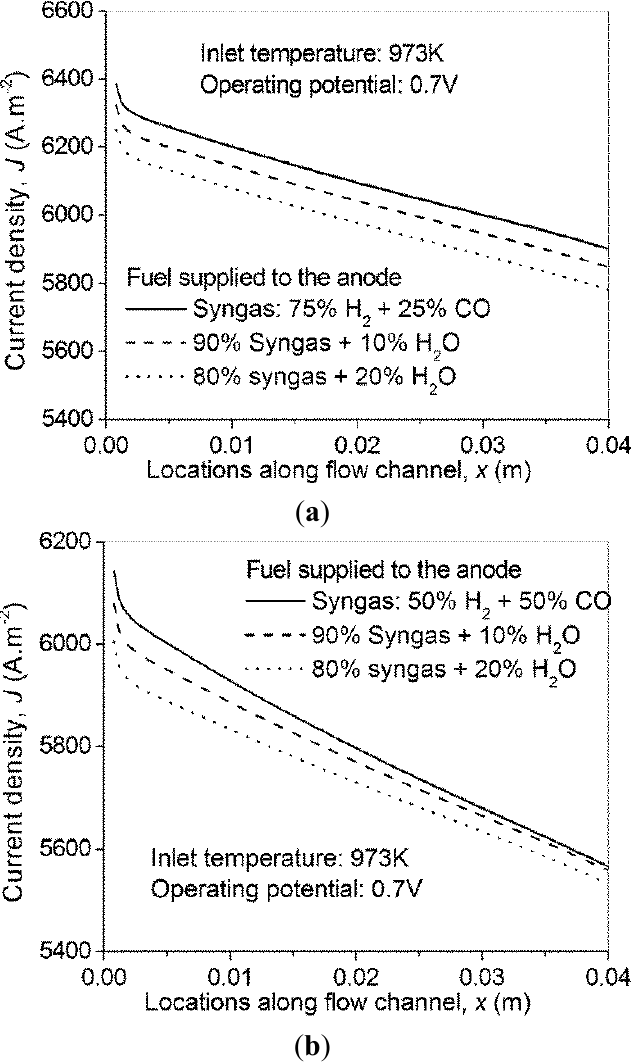
Figure 7. Effect of steam addition on performance of syngas fueled H-SOFC—( a ) syngas with H /CO molar ratio of 3/1; and ( b ) syngas with H 2